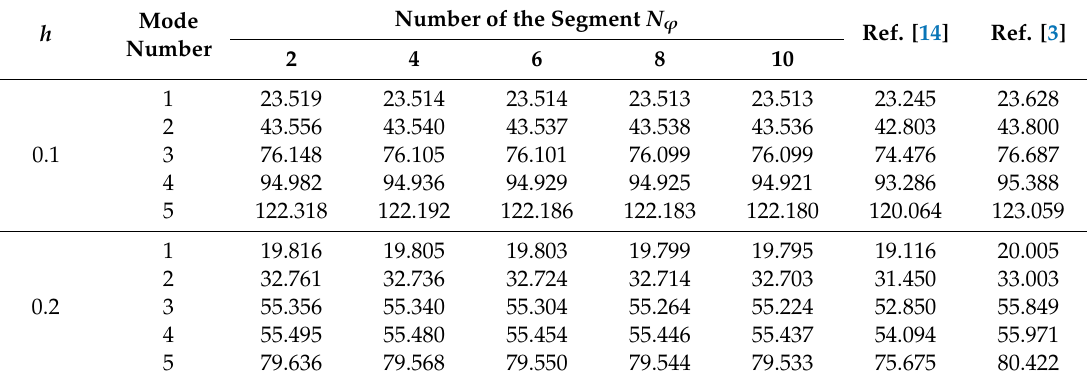
Table 2. Comparison of dimensionless frequencies Ω (first five modes) for a C-C curved laminated composite beam with respect to di ff erent N ϕ